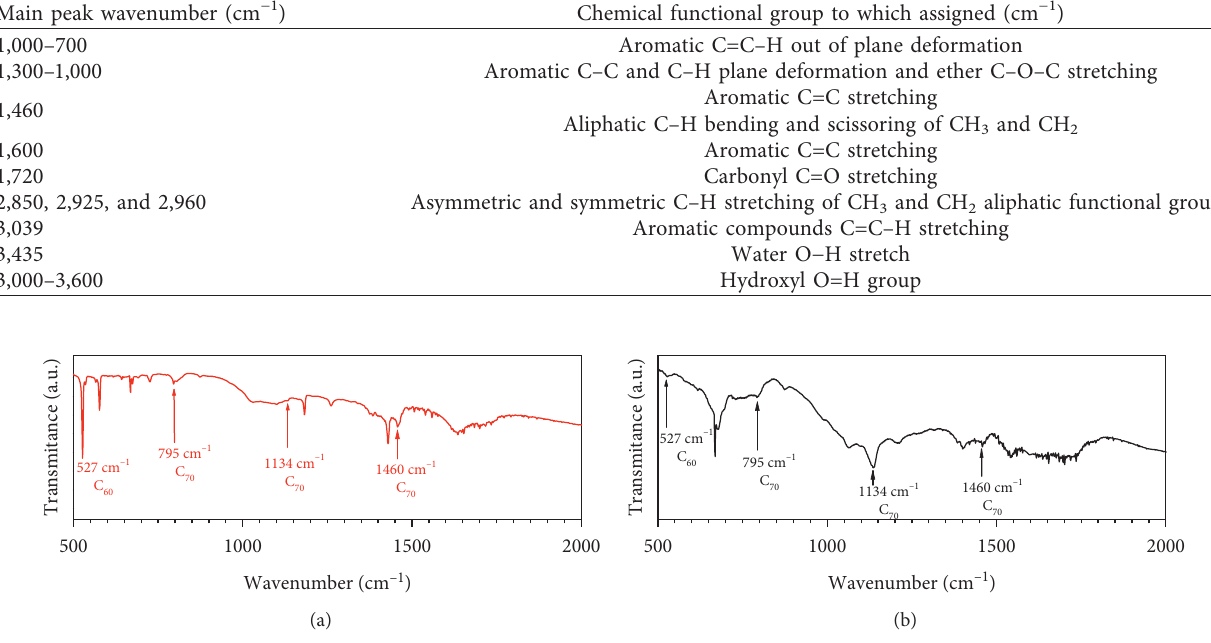
� 204J · cm − 2 . (b) 2 laser. φ